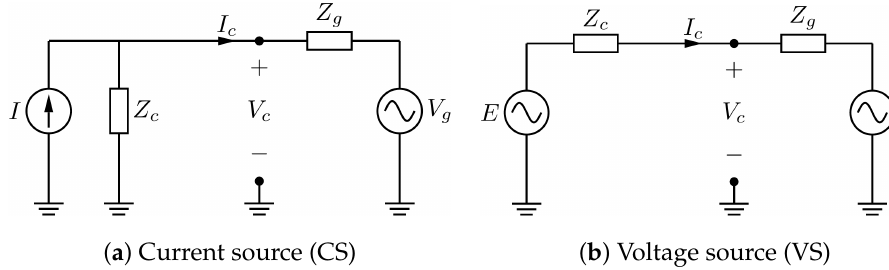
Figure 7. Converter topologies (approximations).